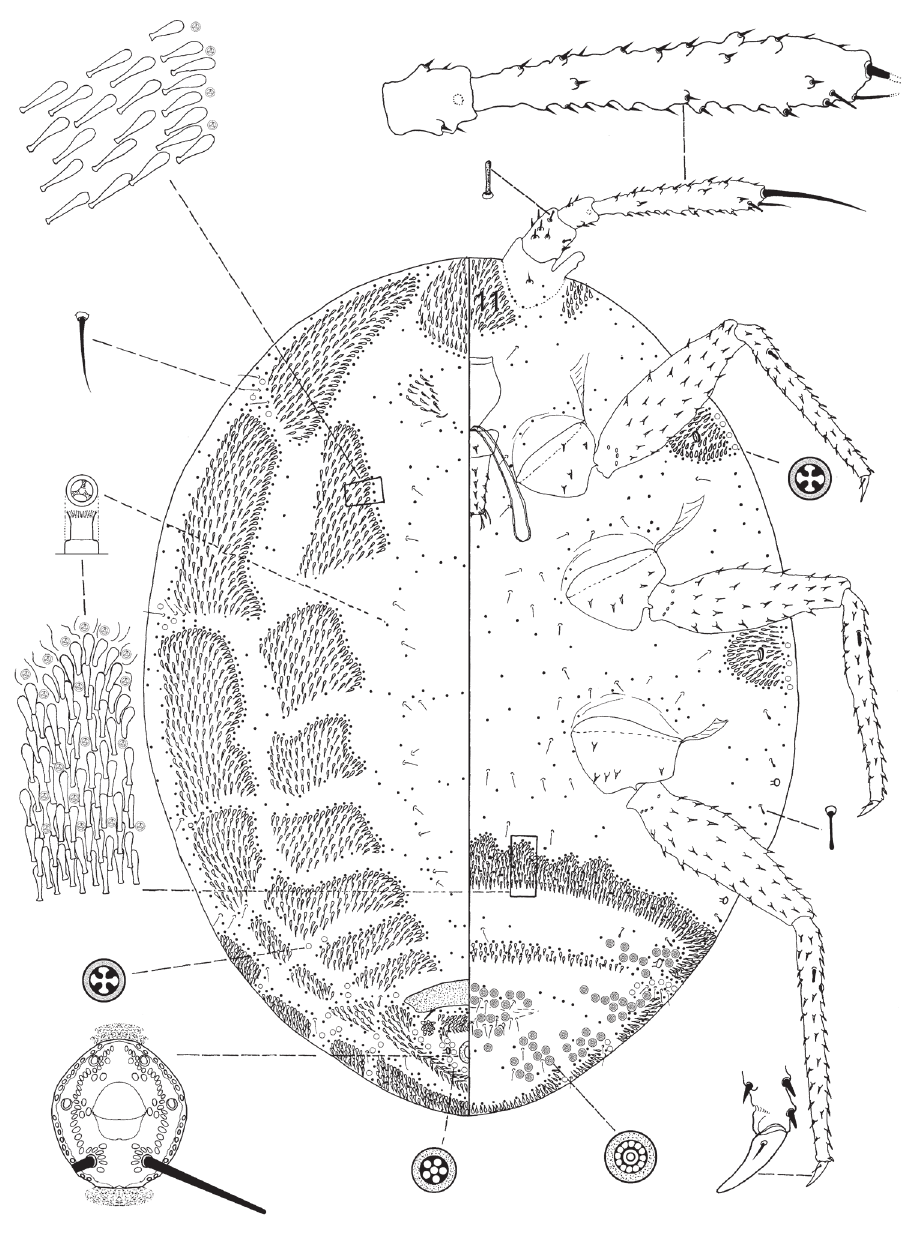
Figure 2. Ortheziola marottai Kaydan & Szita sp. n., holotype, adult female. and normal plate between antennae (plate 11), with marginal wax band surrounding each thoracic spiracle (plates 15 and 16); without triangular-shaped wax plates in front of coxae (plates 13, 17, 18 and 19); without cluster of spines between hind